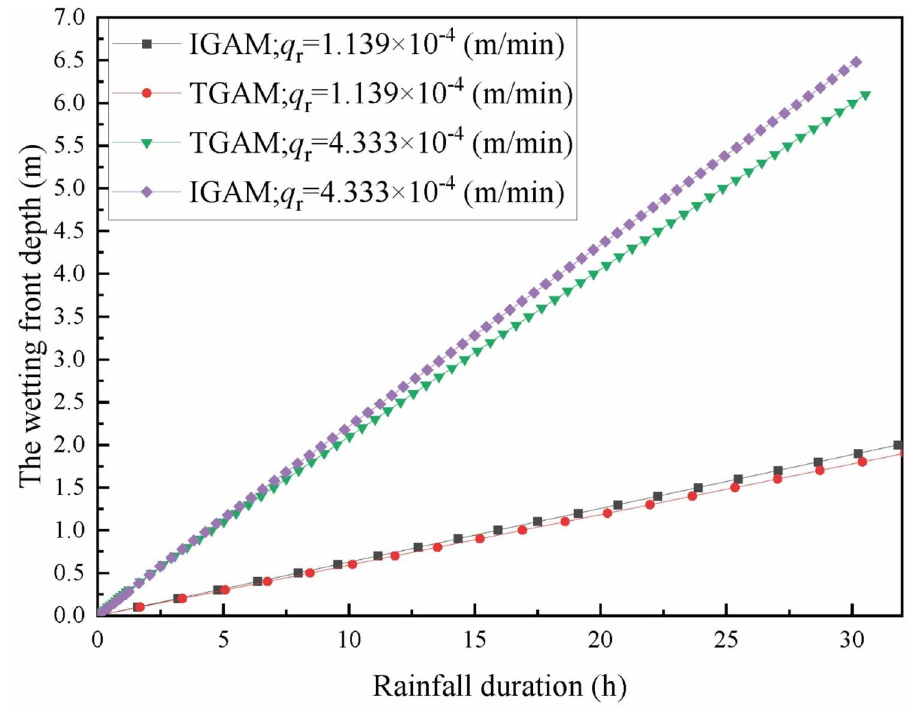
Figure 9. Variation of wetting front depth with rainfall time under different rainfall intensities.